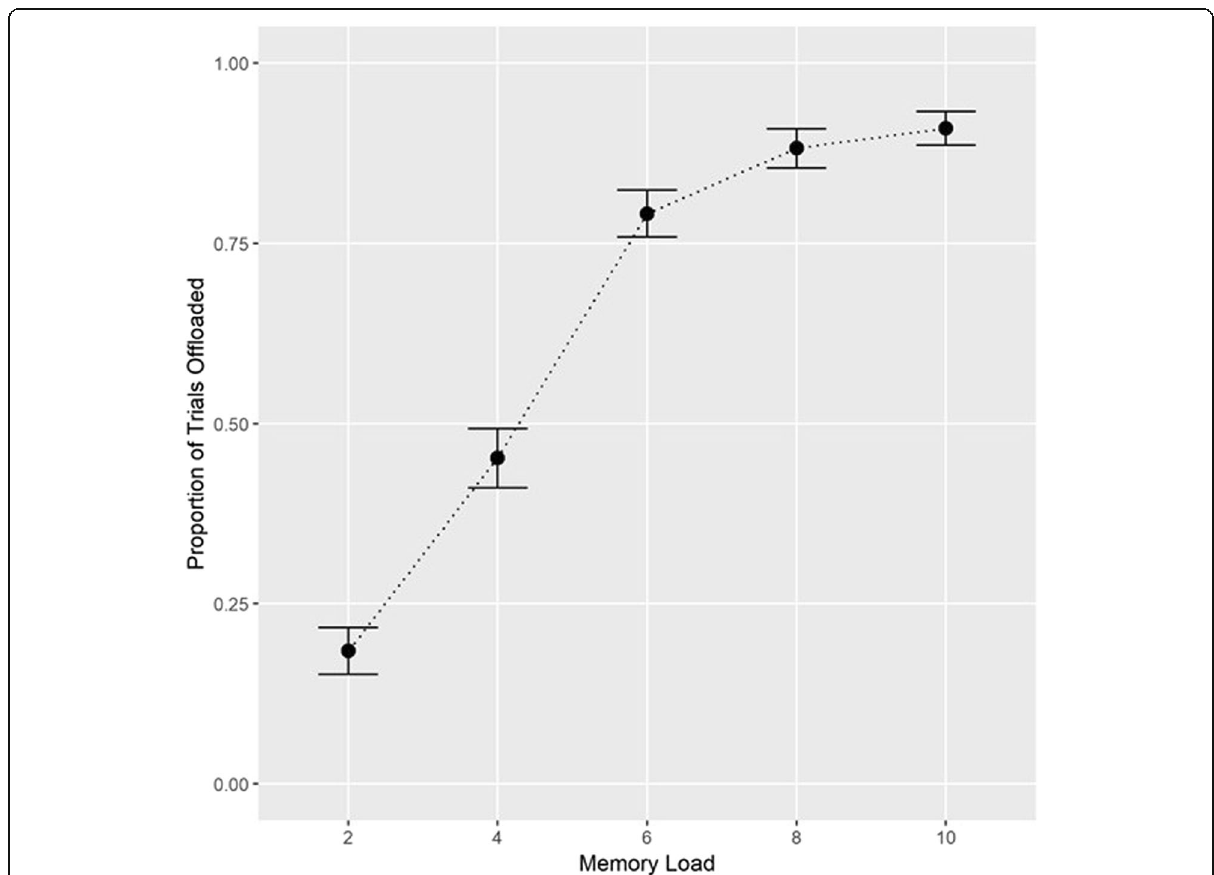
Fig. 3 Average proportion of trials offloaded by set size in the choice block. Error bars denote standard error